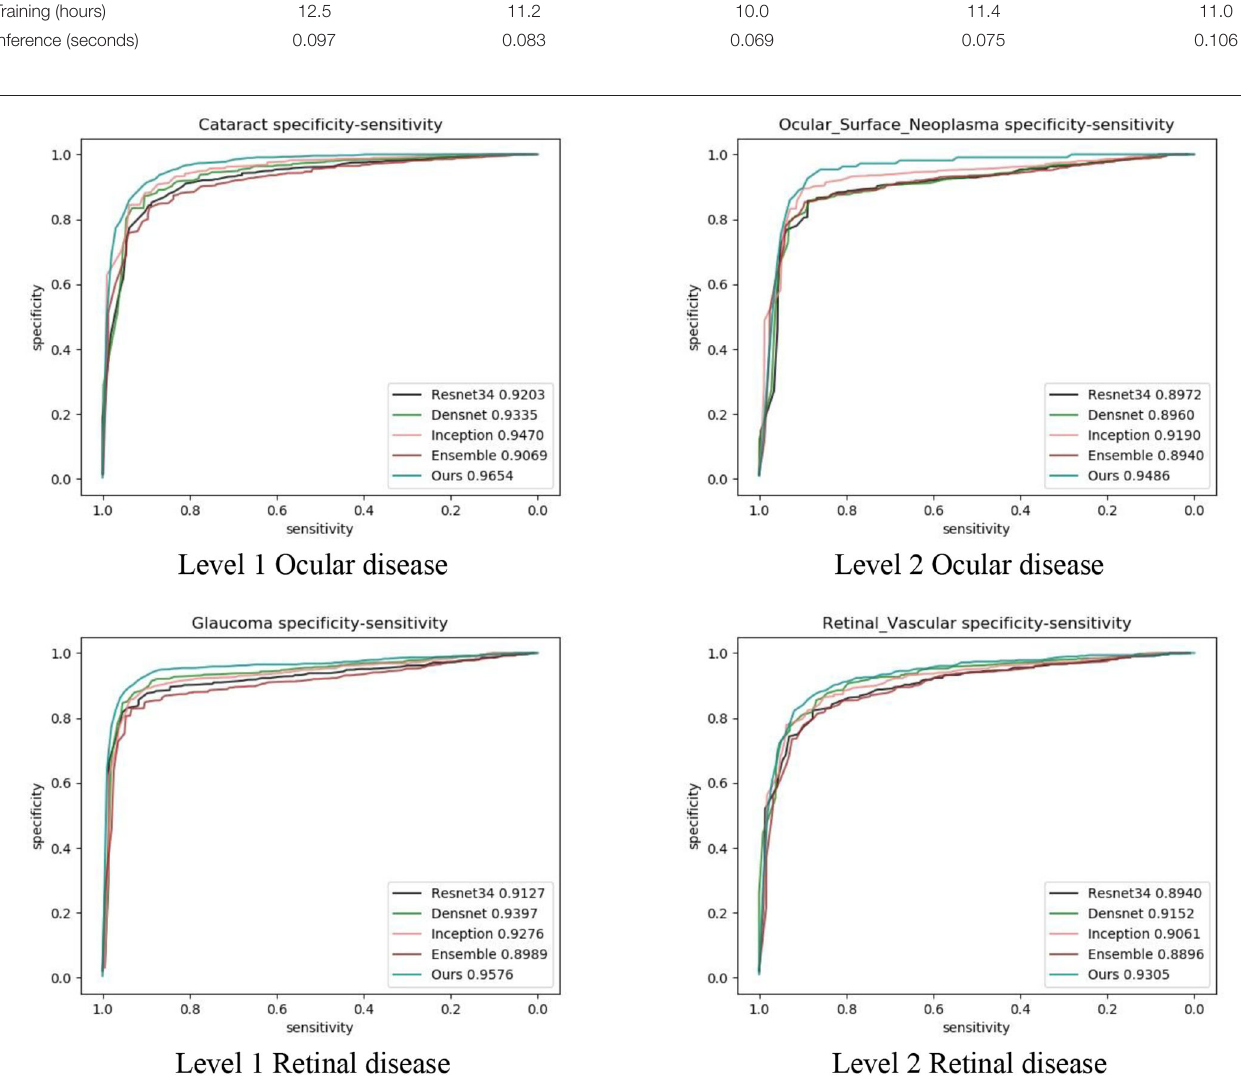
FIGURE 7 | Performance comparison with four deep learning